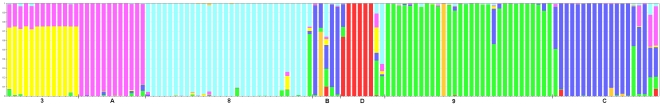
Average assignment probability of a subsample of individuals of Eriosoma lanigerum (aphid host), independent of sampling origin, based on 100 repetitions of 50,000 sweeps using TESS showing K = 7 genetic clusters, ordered showing neighbouring sites between both host plants (Malus domestica and Pyracantha coccinea).3 = Cañadilla-Malus, A = Cañadilla-Pyracantha, 8 = Las Rastras-Malus, B = Las Rastras-Pyracantha, D = Los Manzanos–Pyracantha, 9 = Colin-Malus, C = Colin-Pyracantha.